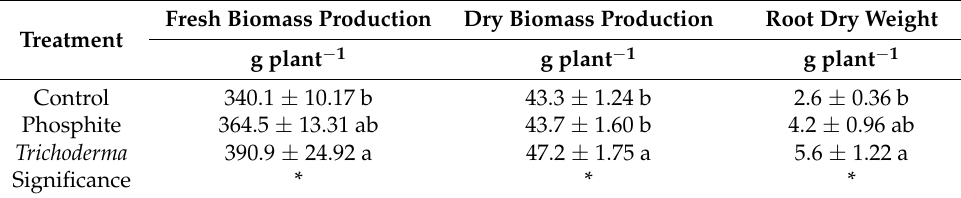
Table 1. Effects of phosphite and Trichoderma application on fresh biomass production, dry biomass production, and root dry weight of zucchini squash